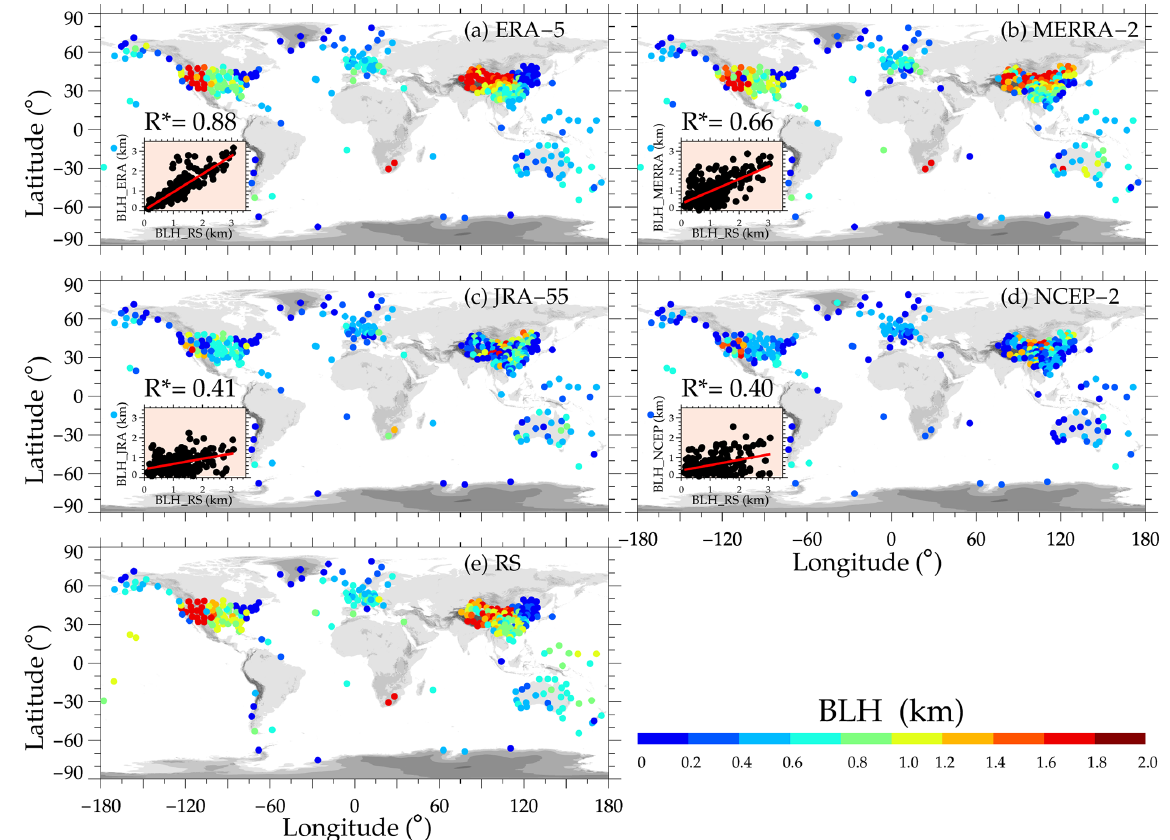
Figure 3. Spatial distributions of the mean BLHs determined at the near-global high-resolution radiosonde observational network locations during the daytime for the period 2012 to 2019 which are extracted from ERA5 (a) , MERRA-2 (b) , JRA-55 (c) , NCEP-2 (d) , and radiosonde (e) measurements. Similar to Fig. 2, the scatter plot illustrates the correlations between reanalysis-derived and sonde-determined BLHs in the